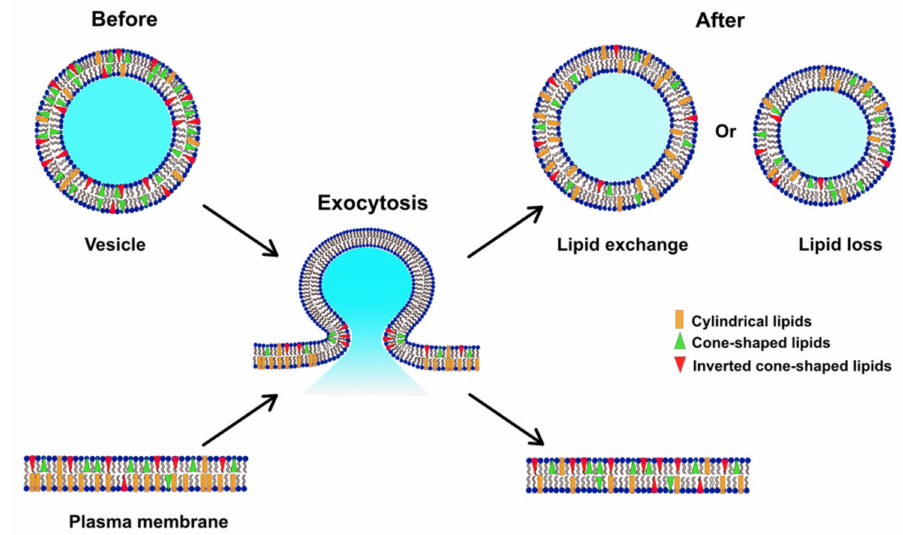
Figure 4. Model illustrating how the lipid composition of the plasma membrane might be altered during exocytosis induced by repetitive